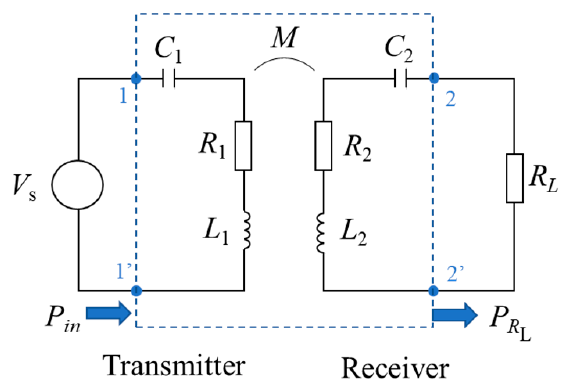
Figure 2. Equivalent lumped-circuit model of the four-coil MRC-WPT system.